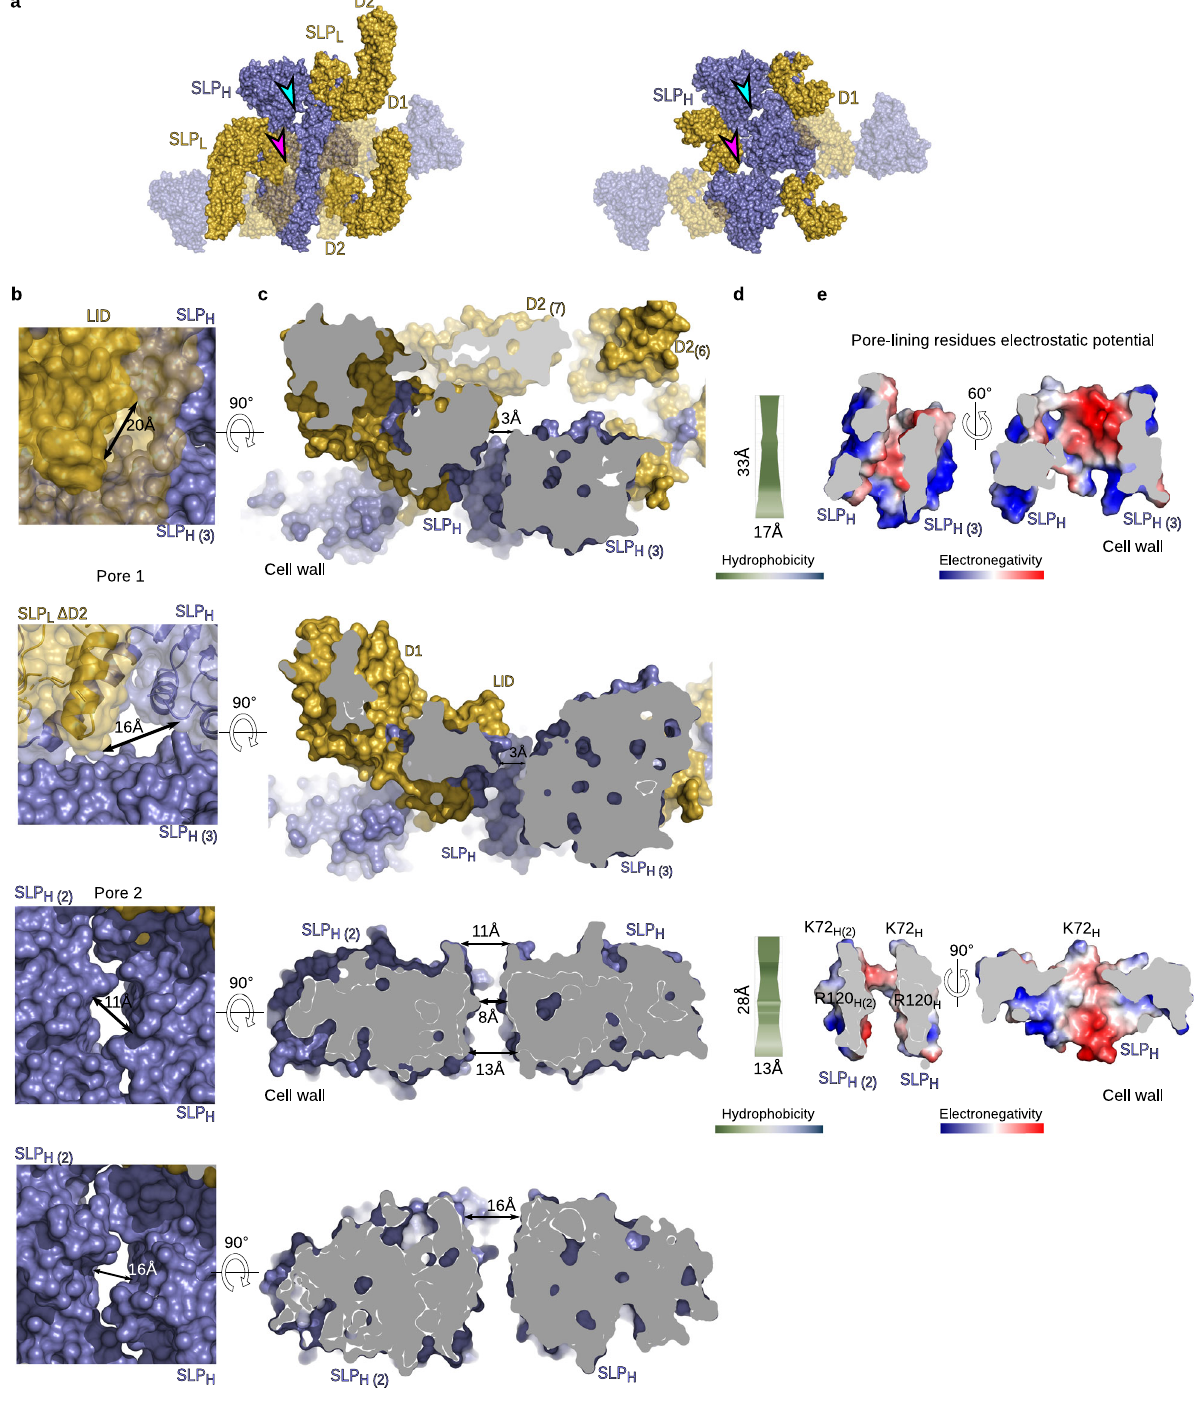
Fig. 5 C. dif fi cile S-layer is a tightly packed array with very narrow pores. a Surface representation of wild-type H/L (7ACY, left) and SlpA R Δ D2 H/L (7ACZ, right) crystal packing showing pores in the 3D crystal lattice. Positions of pores marked with arrowheads (pore 1 in magenta, pore 2 in cyan) are equivalent in both lattices. b Zoomed-in view of the pores generated by H/L multimerization. Pore 1, top view covered by D2 in SlpA CD630 ( fi rst panel) and in SlpA R Δ D2 (second panel). Pore 2 – top view for SlpA CD630 (third panel) and SlpA R Δ D2 (fourth panel). Widest openings are labelled for each pore. Arrows indicate the widest points in each pore, which are exposed in SlpA R Δ D2 due to the lack of D2 that completely covers it in SlpA CD630 . c Cross-section views of pore 1 and pore 2 in SlpA CD630 ( fi rst and third panels, respectively) and SlpA R Δ D2 (second and fourth panels, respectively). Neighbouring SLP H (slate blue) and SLP L (gold) molecules that create the pores are shown in surface representation. d Hydrophobicity characteristics of the residues lining pore 1 (top) and 2 (bottom) calculated in ChexVis (see Methods section for details) according to Kyte-Doolittle scale, ranging from hydrophilic (green) to hydrophobic (blue), as per hydrophobicity gradient key. e Poisson – Boltzmann electrostatic potential calculated for residues lining pore 1 ( fi rst panel) and 2 (second panel) in SlpA CD630 represented as a charge distribution (positive in blue and negative in red, as per electronegativity gradient key). Views and scale are as in c (left) and as a slice across the largest pore surface (right). Pseudo-symmetry-related lysine residues at the top and arginine residues at the bottleneck of pore 2 are